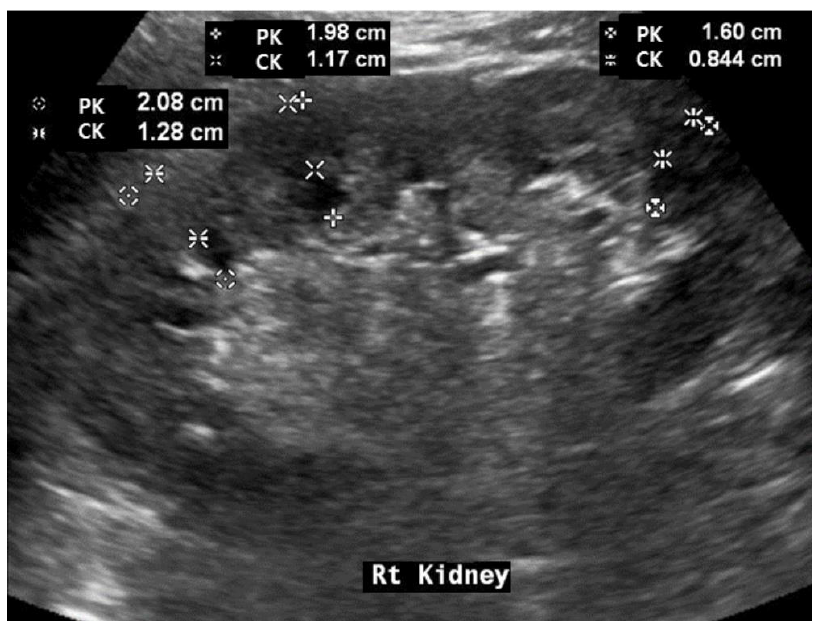
Figure 2. Representative picture of measurements using renal scoring. Table 1. Renal scoring calculation for representative patient.